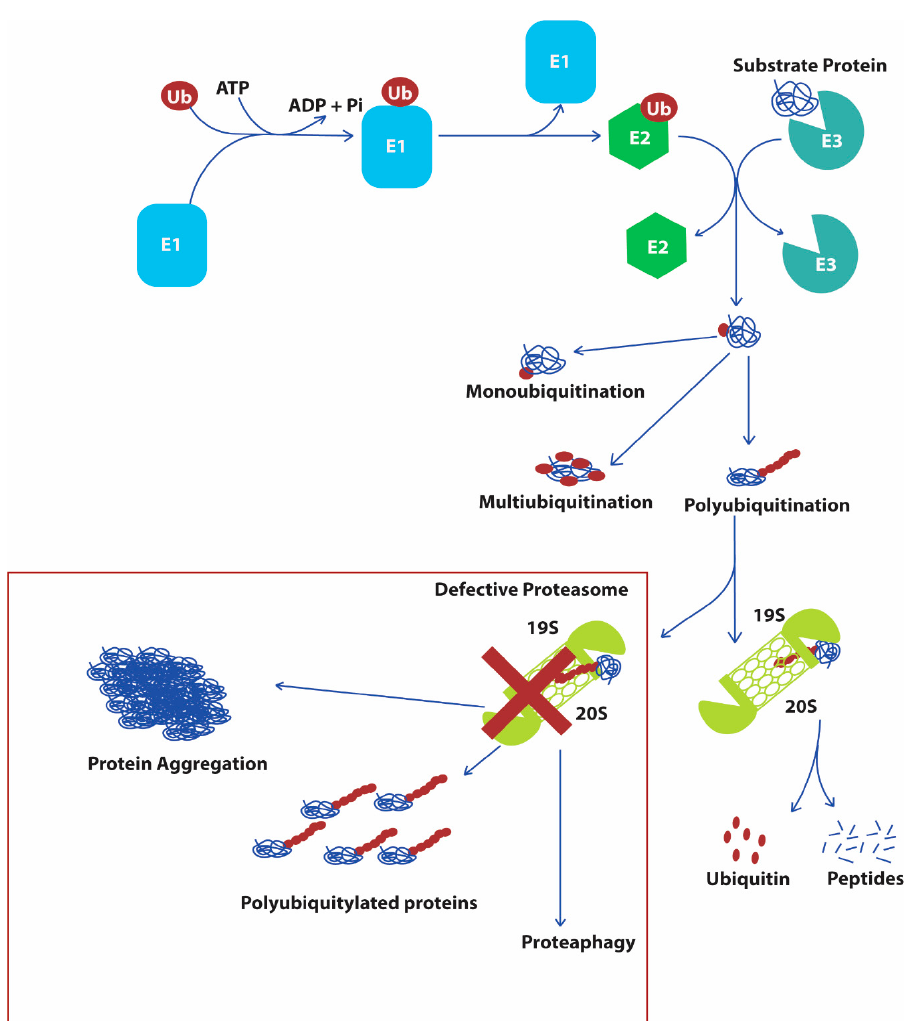
Figure 4. Schematic diagram showing degradation of substrate protein by the UPS and fates of defective proteasomal system. Ub, ubiquitin; ATP, adenosine triphosphate. The first step in ubiquitin proteasome system requires the activated E1 activating enzyme to activate the ubiquitin. Following the activation of ubiquitin, E1 enzyme transfers the activated ubiquitin molecule to E2 conjugating enzyme. At the same time, E3 ligating enzyme conjugates with the substrate protein, which is then conjugated with ubiquitin bound to E2 enzyme. The chain of ubiquitin is elongated by multiple cycles of ubiquitination. The ubiquitinated proteins are then recognized and degraded by the 26S proteasome, while the failure to degrade the polyubiquitinated proteins due to defective proteasome may result in protein aggregation, abundance of polyubiquitinated proteins, and impaired protein turnover. The defective proteasome may get recycled through proteaphagy. Table 2. Yeast ubiquitins, E1 activating enzymes, and E2 conjugating enzymes conserved in humans that are involved in polyubiquitylation of substrate protein .